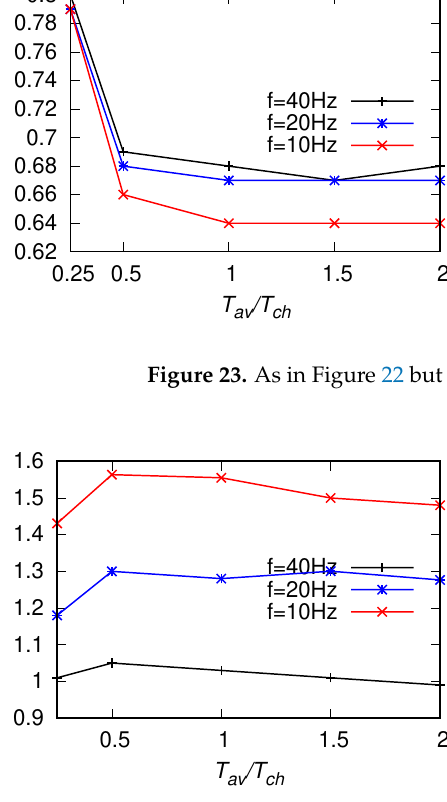
Figure 24. Statistics of (cid:101) NCF estimates based on the number of zero-crossings, Equation (9), for the fitting range f = [ 1 ÷ 5 ] Hz, from POST signals [15] with f s = 40 Hz, 20 Hz and 10 Hz. Left panel : EDR averaged along the signal, right panel : standard deviation of the estimates.